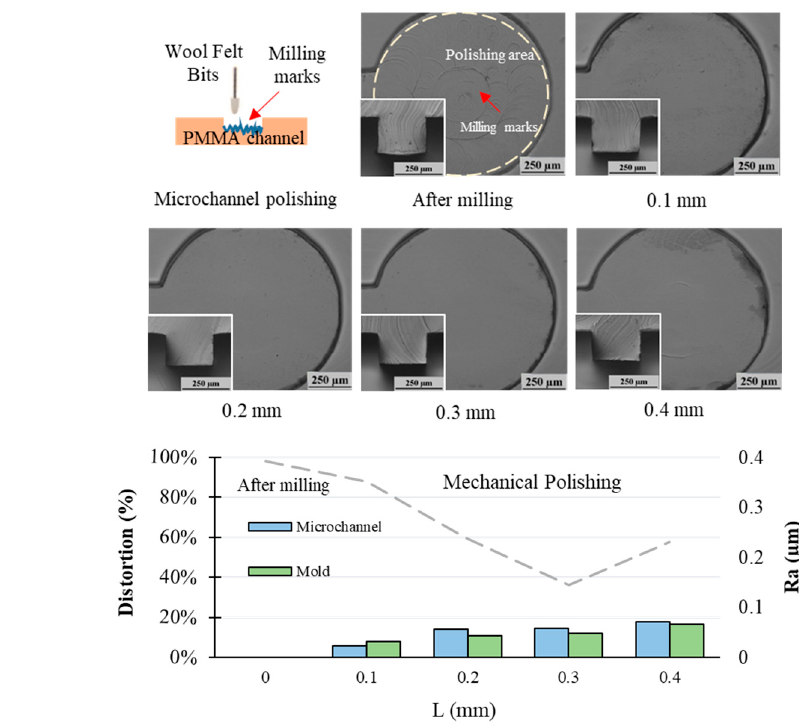
Figure 6. Top and cross-sectional (left-bottom) microscope images of a ( a ) micromold and ( b ) microchannel after milling (0 min) and after mechanical polishing at a pressing length of 0.4 mm. ( c ) Summary of distortion percentage and surface roughness (Ra).